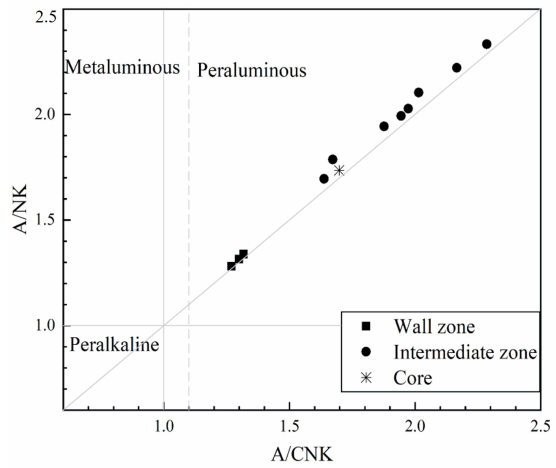
Figure 6. The A/CNK-A/NK discriminant diagram for Lijiapuzi pegmatite.